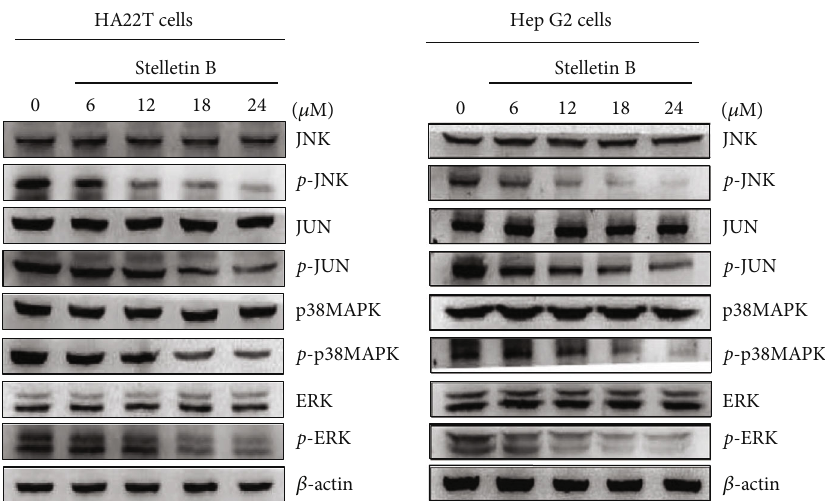
Figure 7: E ff ects of Stellettin B on the MAPKs signaling pathway. HA22T and HepG2 cells were treated with di ff erent concentrations of Stellettin B (0, 6, 12, 18, and 24 μ g/mL) and cell lysates were collected for western blotting analysis. The MAPKs-related proteins were validated, including p38MAPK, p -p38MAPK, ERK, p -ERK, JNK, p -JNK, JUN, and p -JUN. Zero refers to cells treated with DMSO vehicle as a control. β -Actin was used as the internal